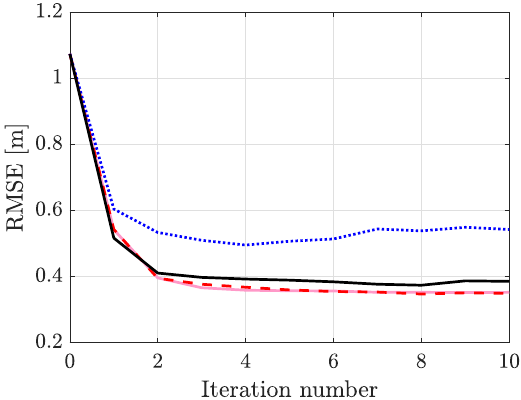
Figure 7. Comparison of different parameter estimation algorithms as a function of iteration number: EM( Θ { 1 } ) ( ), NLS( Θ { 1 } ) ( ), NLS( Θ { 2 } ) ( ) and NLS( Θ { 3 } ) (